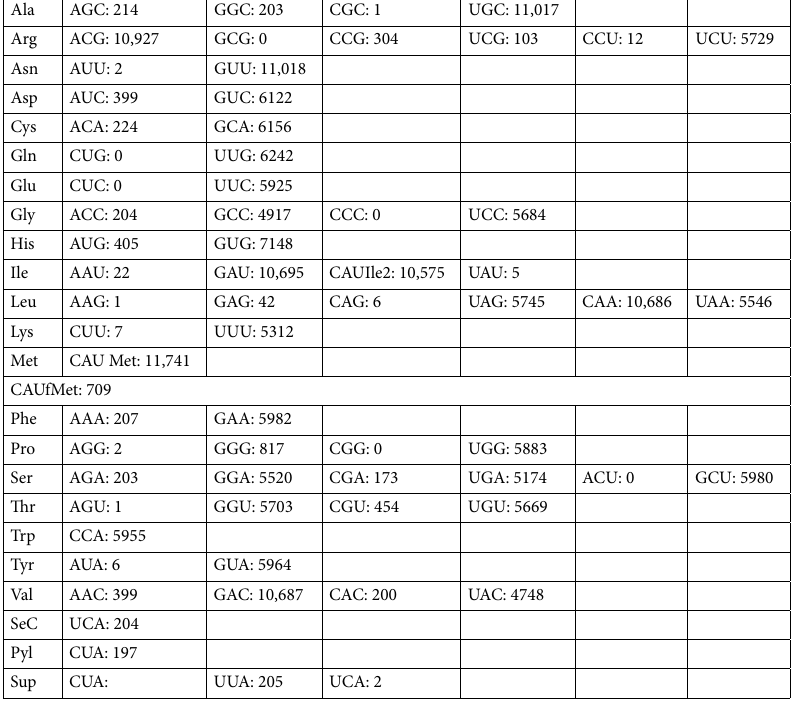
Table 1. Anticodon Table of the chloroplast genome. Study from 5959 chloroplast genomes shows several rare